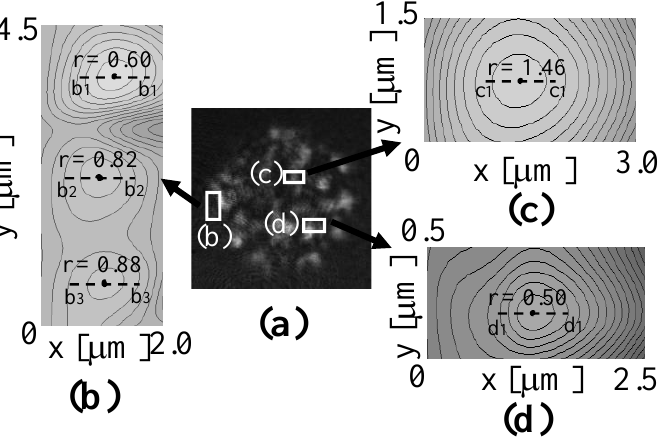
Figure 8. Measured results: ( a ) Measurement area in the speckle interferogram (same image of Figure 5a); ( b ) Measured shape in area; ( c ) Measured shape in area; ( d ) Measured shape in area.